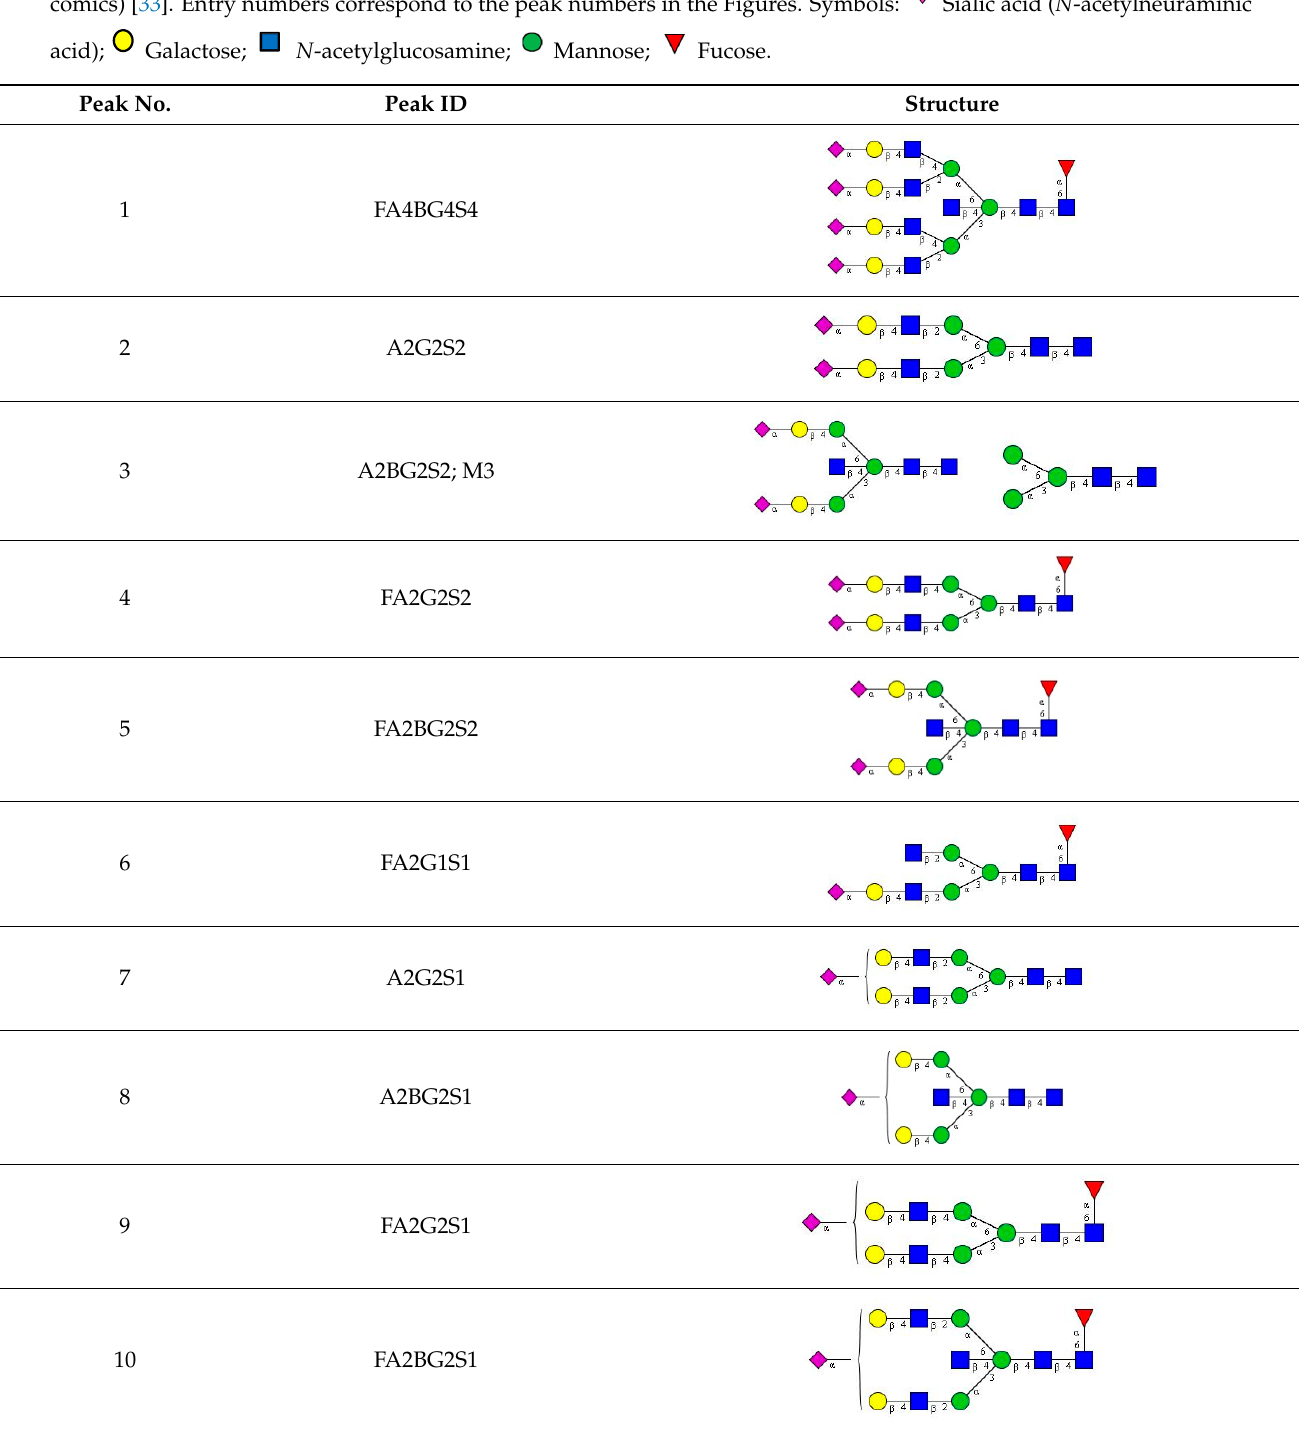
Table 1. Identified N -glycan structures (nomenclature followed the guidelines of the Consortium of Functional Glycomics) [33]. Entry numbers correspond to the peak numbers in the Figures. Symbols: